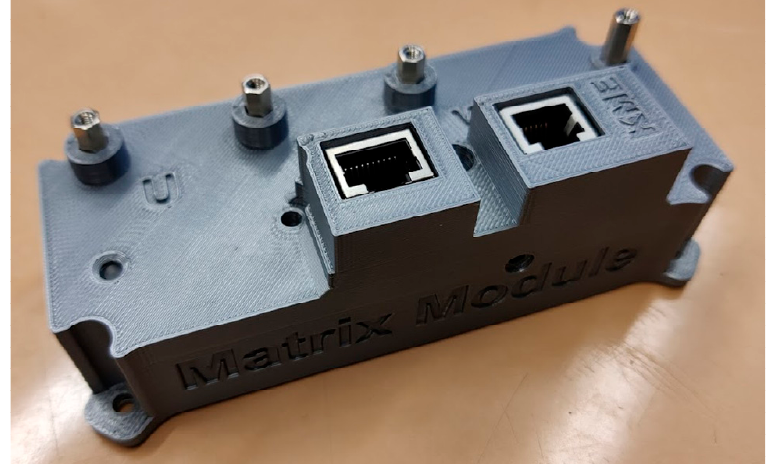
Figure 20. Assembled module with printed protection